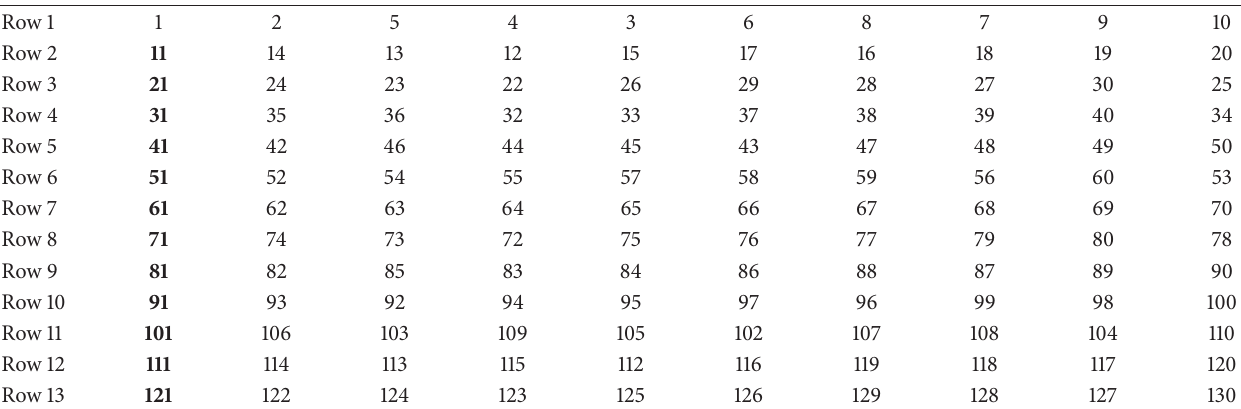
Table 4: The result of row clustering.